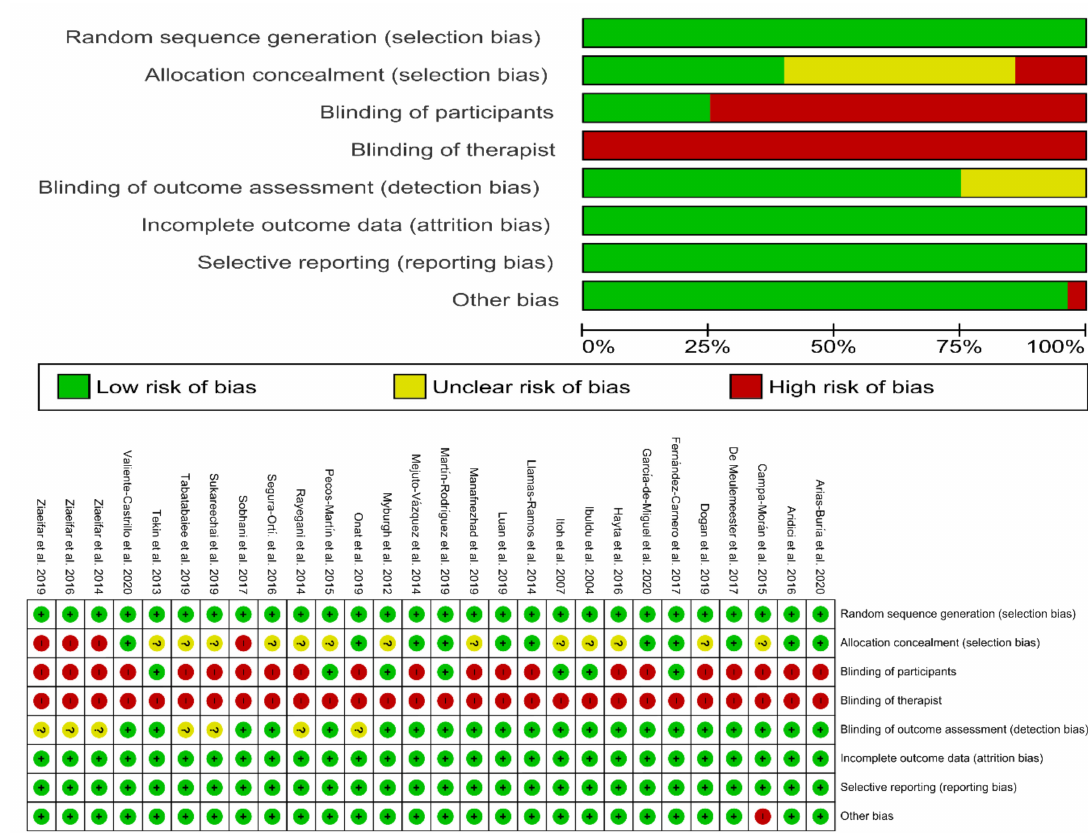
Figure 2. Plot of the risk of bias of the included